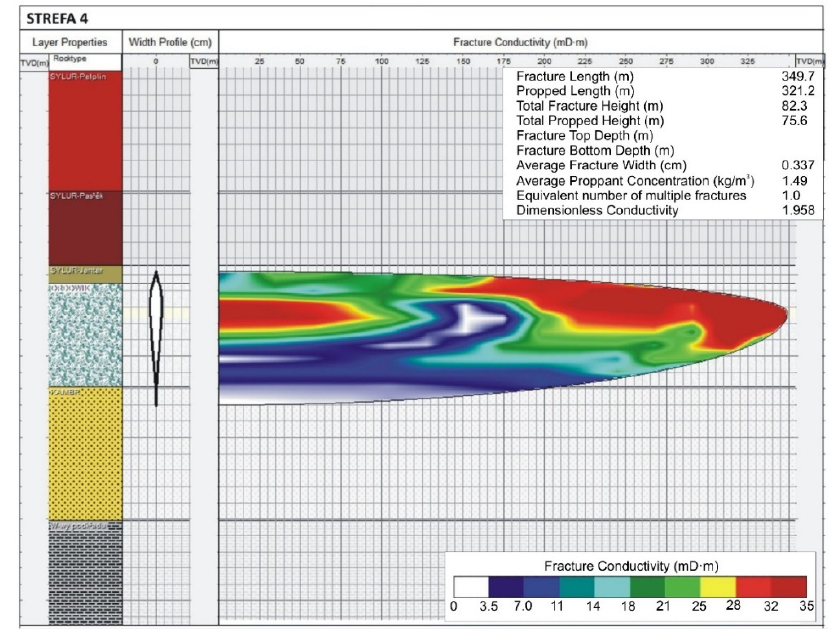
Figure 2. An exemplary model of a wing of the fracture. Color filling means fracture conductivity [15].